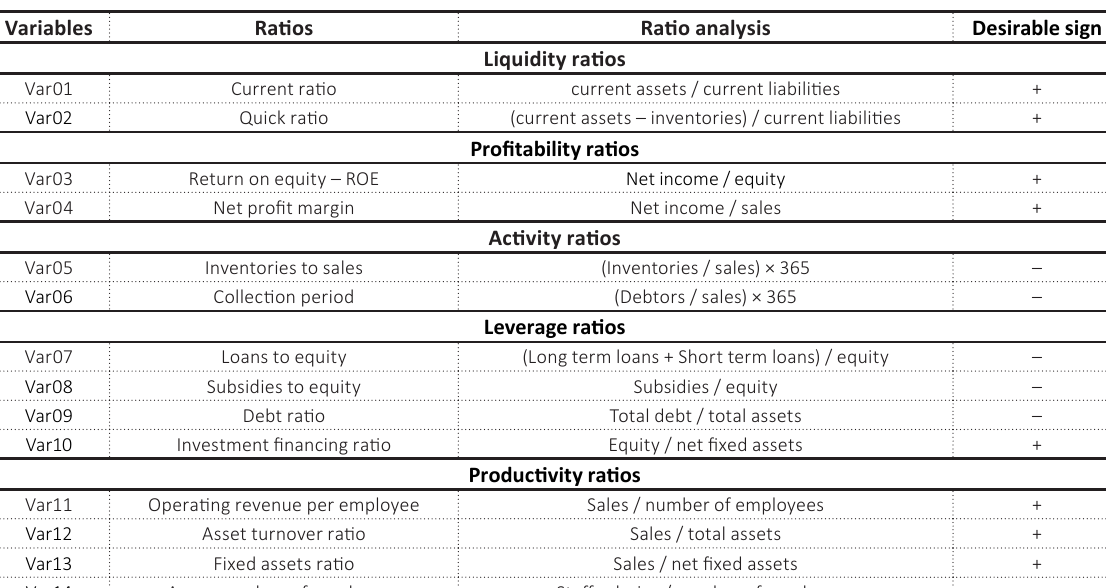
Table 1. Financial